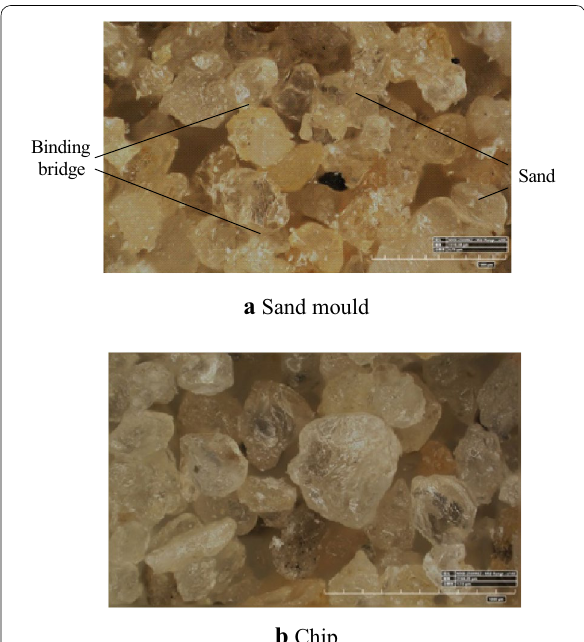
Figure 1 Micrograph of sand mould and